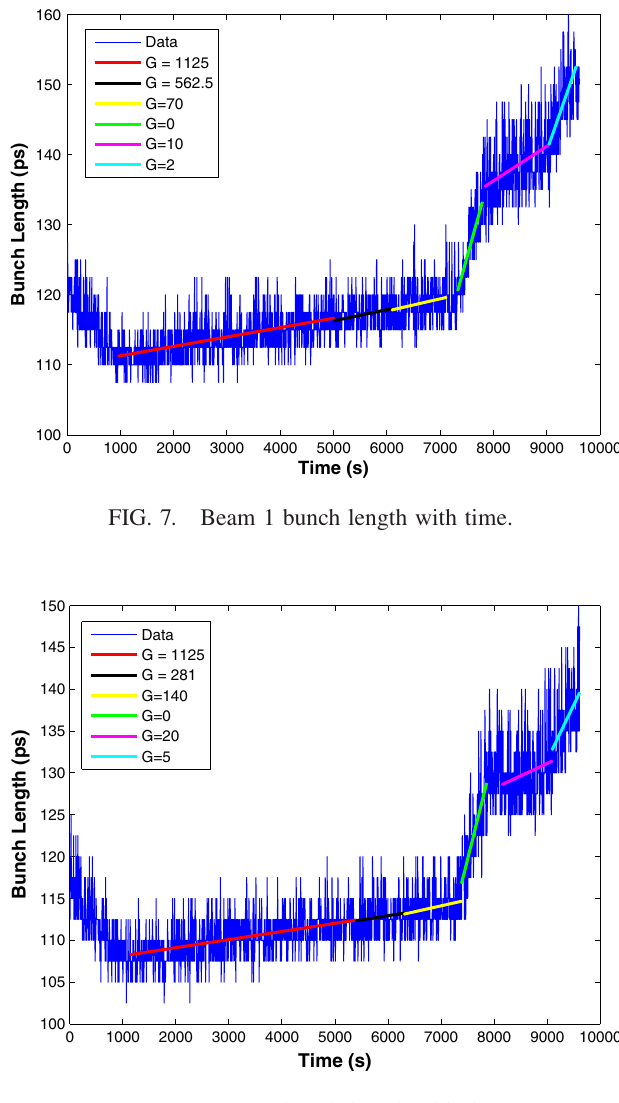
FIG. 8. Beam 2 bunch length with